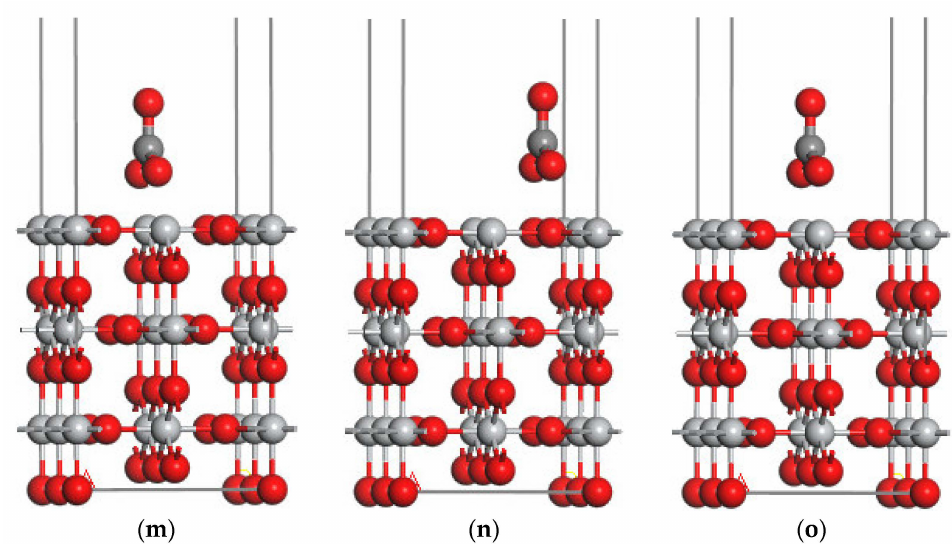
Figure 2. Interface model of TiO 2 (110) containing different corrosive species: ( a ) TiO 2 (top)—Cl − ; ( b ) TiO 2 (bridge)—Cl − ; ( c ) TiO 2 (hole)—Cl − ; ( d ) TiO 2 (top)—HS − ; ( e ) TiO 2 (bridge)—HS − ; ( f ) TiO 2 (hole)—HS − ; ( g ) TiO 2 (top)—S 2 − ; ( h ) TiO 2 (bridge)—S 2 − ; ( i ) TiO 2 (hole)—S 2 − ; ( j ) TiO 2 (top)—HCO 3 − ; ( k ) TiO 2 (bridge)—HCO 3 − ; ( l ) TiO 2 (hole)—HCO 3 − ; ( m ) TiO 2 (top)—CO 32 − ; ( n ) TiO 2 (bridge)—CO 32 − ; ( o ) TiO 2 (hole)—CO 32 − .